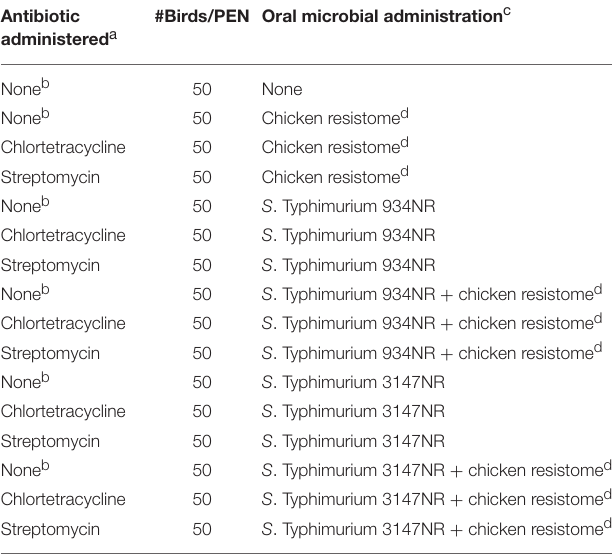
TABLE 2 | Animal Study 2: Does antibiotic administration enhance acquisition of antimicrobial resistance in Salmonella in vivo from the chicken resistome? Antibiotic administered